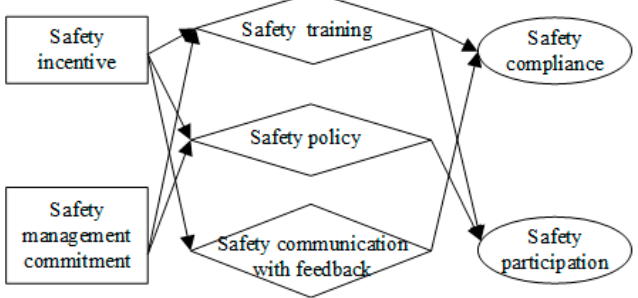
Figure 5. The path of effects on employee safety behaviour.